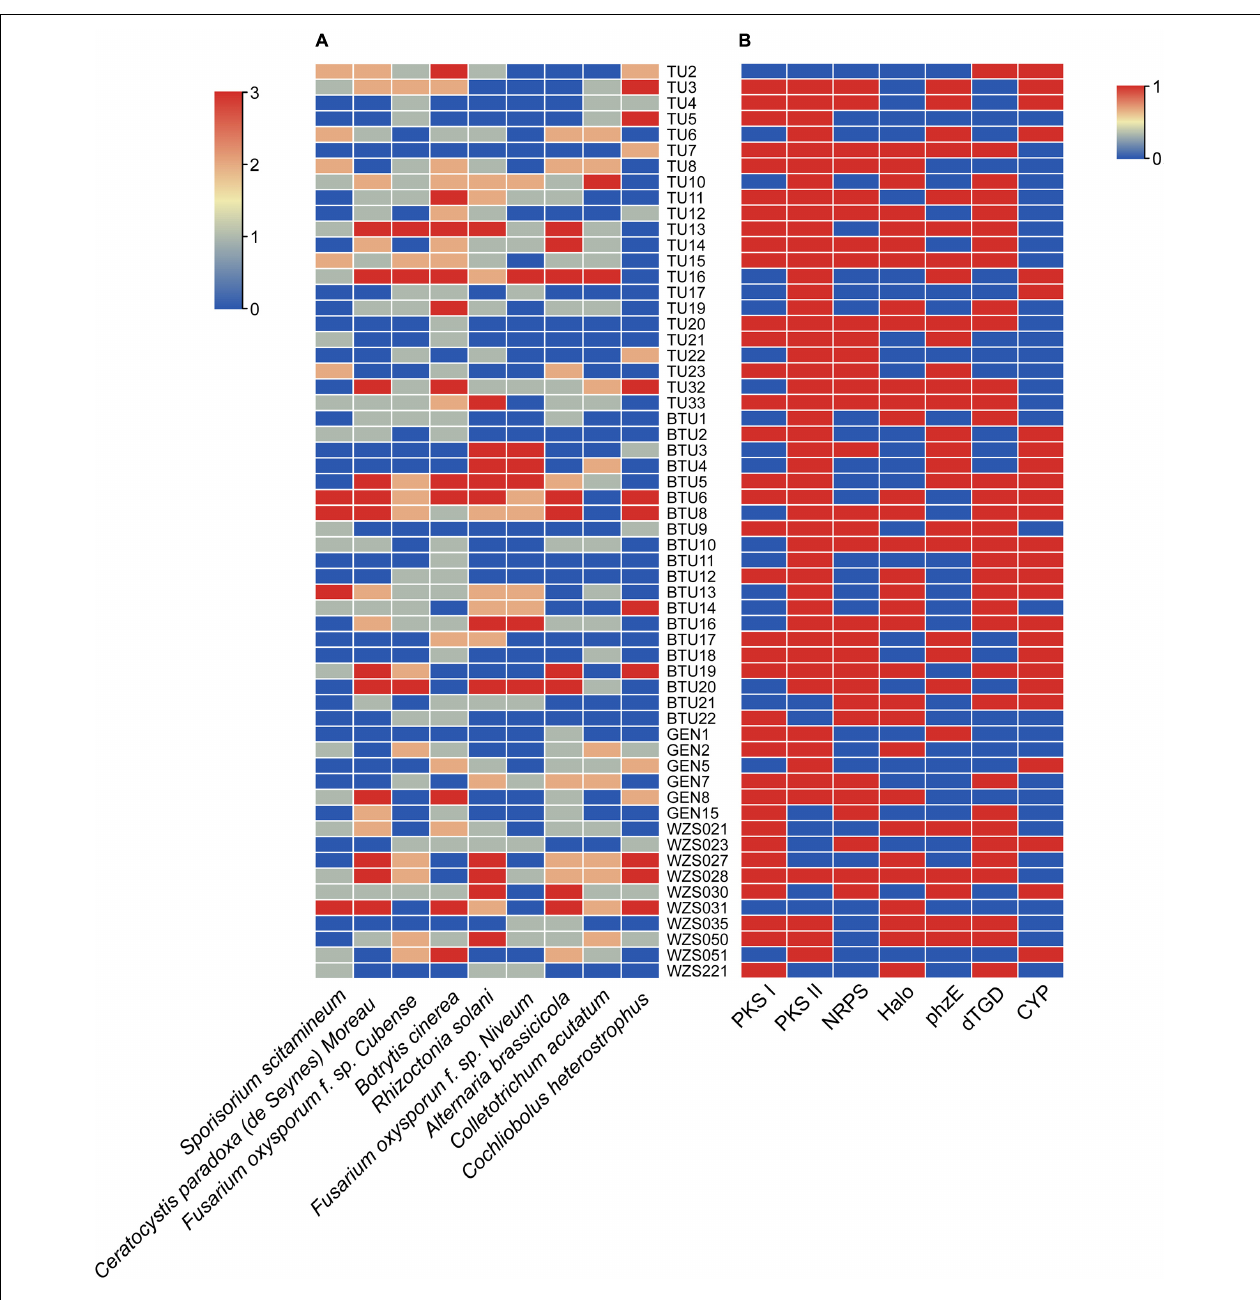
FIGURE 2 | In vitro antagonism of actinobacteria and phytopathogenic fungi (A) , and screening of synthetic genes for secondary metabolites of actinobacteria (B) . (A) Growth definitely retarded with zone of inhibition (1) near the colony, (2) of ≥ 10 mm, and (3) of ≥ 15 mm. (0) Represents no inhibition. (B) (0) Negative; (1) positive.